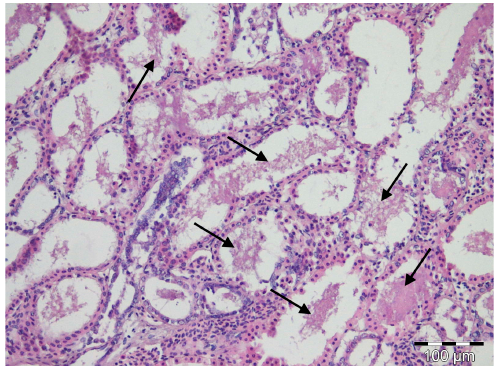
Figure 2. Light micrograph of a histological section through the kidney of a nursehound shark Scylliorhinus stellaris showing deposits of a basophilic amorphous material (black arrows) in the lumen of renal tubules. MHE staining.